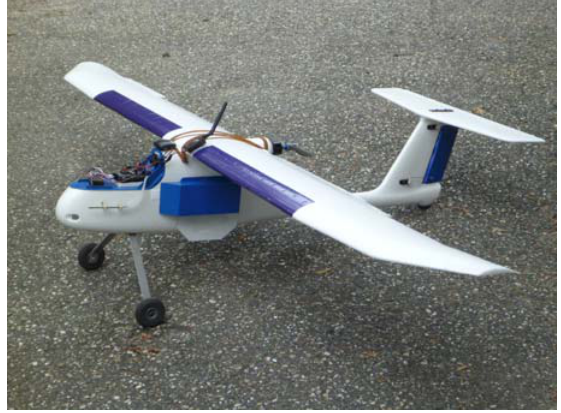
Figure 1. The Study UAV This aircraft has low wing loading, good stability, low